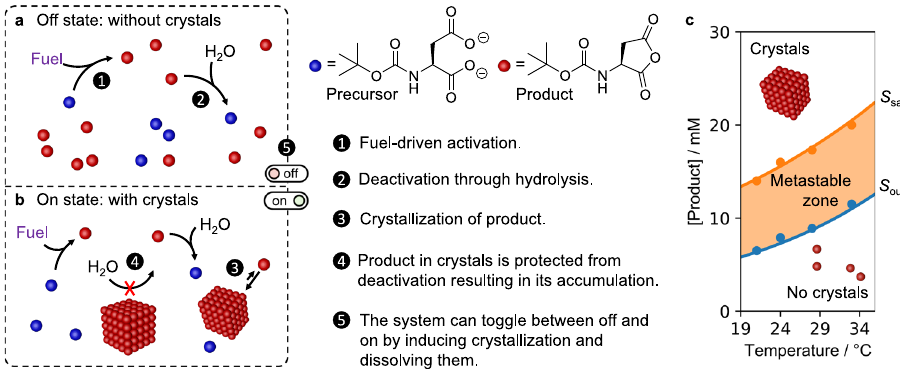
Fig. 1 Mechanisms for bistability in chemically fueled crystals. Two possible states can emerge in one experiment either an ( a ), off-state without crystals or ( b ), an on-state with crystals. The crystals protect the anhydride from deactivation which serves as the feedback mechanism. c The phase diagram of crystallization of the product. In the metastable window, a solution with or without crystals can exist. Solubility and supersaturation concentrations at various temperatures were experimentally determined (see Supplementary Methods section and Supplementary Fig.